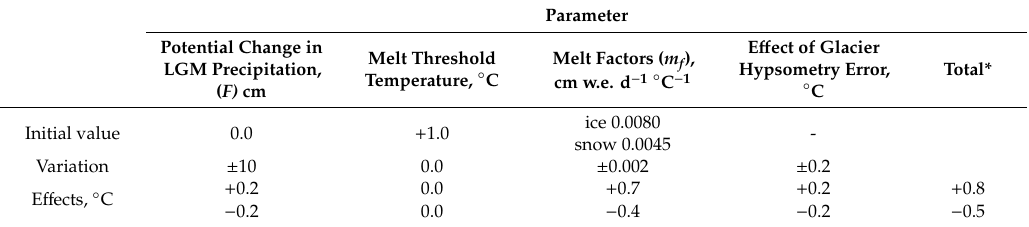
Table 5. Sensitivity of TM simulations to variations of parameter values and resulting uncertainties, grouped by whether the variation increases (positive values) or decreases (negative values) the temperature depression required to maintain steady-state mass balances of